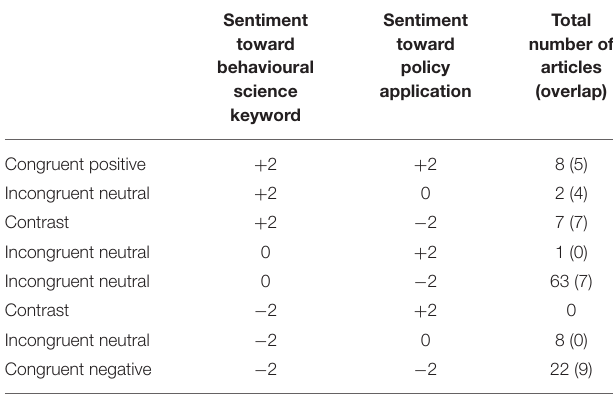
TABLE 2 | Distribution of selected articles across the three time periods (pre-, during-, and post- lockdown) and sentiments toward behavioural science and public